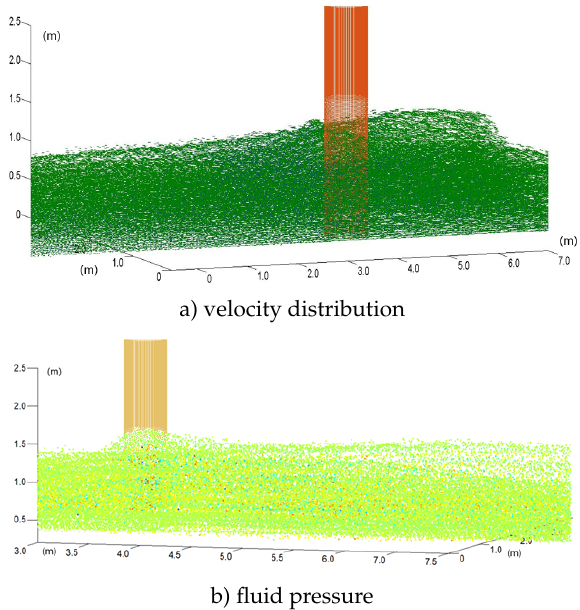
Fig. 6. Velocity distribution (a) and fluid pressure (b) around bridge pier in the SPH